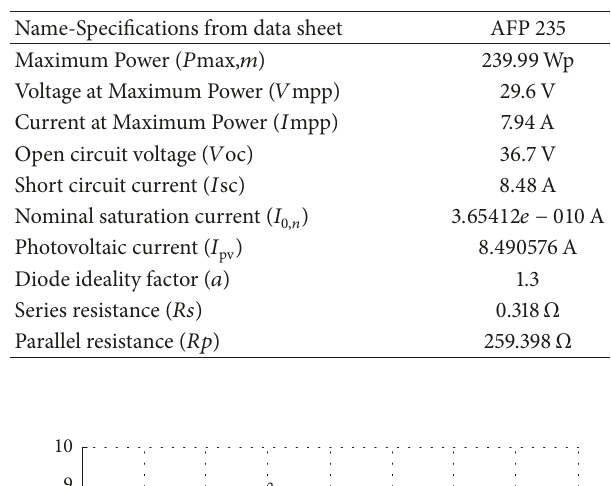
Table 1: Parameters of the Altius, AFP 235 solar module at 25 ∘ C, 1000 W/m 2 [25].